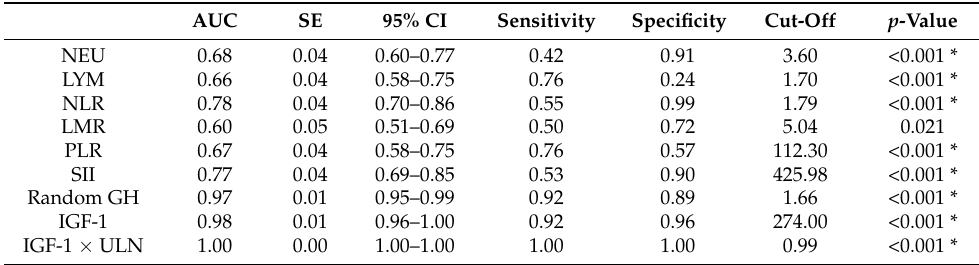
Table 3. Comparison of inflammatory markers and GH/IGF-1 in the distinction of acromegaly from